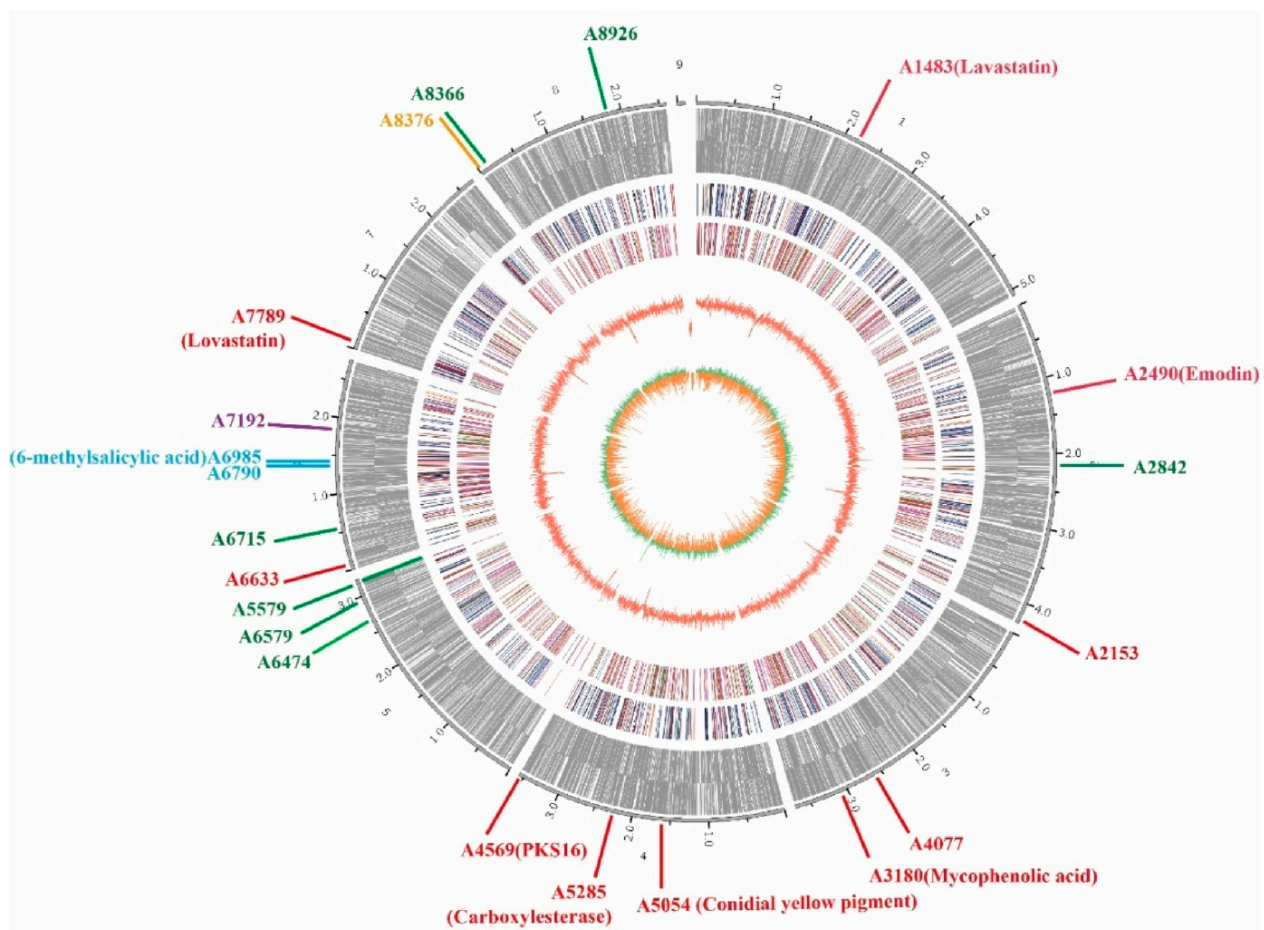
Figure 2. Genome map of Eurotium cristatum E1. From the outside to the inside: the first circle is the genome contig; the second circle is the gene density of the sense strand; the third circle is the gene density of the antisense strand; the fourth and fifth circles are the KOG annotation results; the sixth circle is the GC content calculated with 2000 bp as a window on each contig; the seventh circle is the GC offset. The polyketide synthase (PKS) and nonribosomal peptide synthase (NRPS) genes were shown in the genome map of E . cristatum E1. The red represents PKS gene. The green represents NRPS gene. The blue represents hybrid PKS and NRPS gene. The purple and orange represent indole—PKS and indole—NRPS gene,